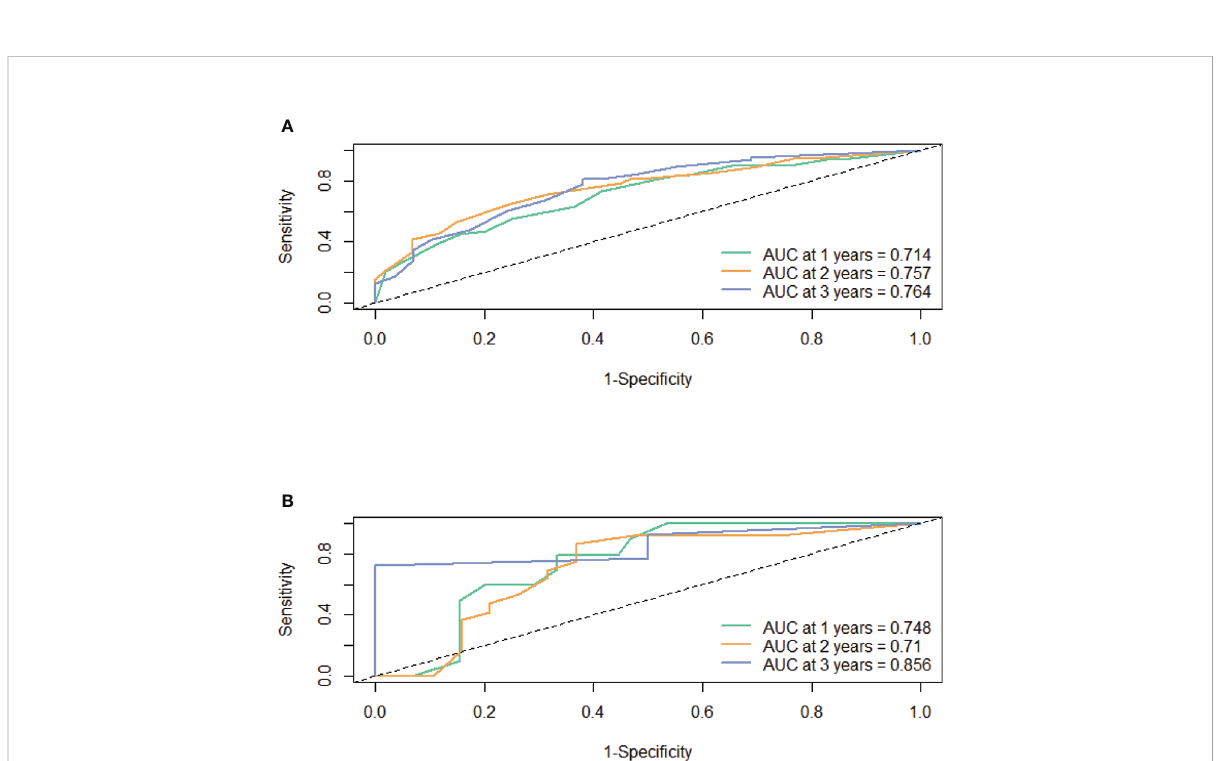
FIGURE 5 The prognostic accuracy of the nomogram was estimated by using ROC curves and AUCs at 1, 2, and 3 years in the training cohort (A) and the external validation cohort (B)